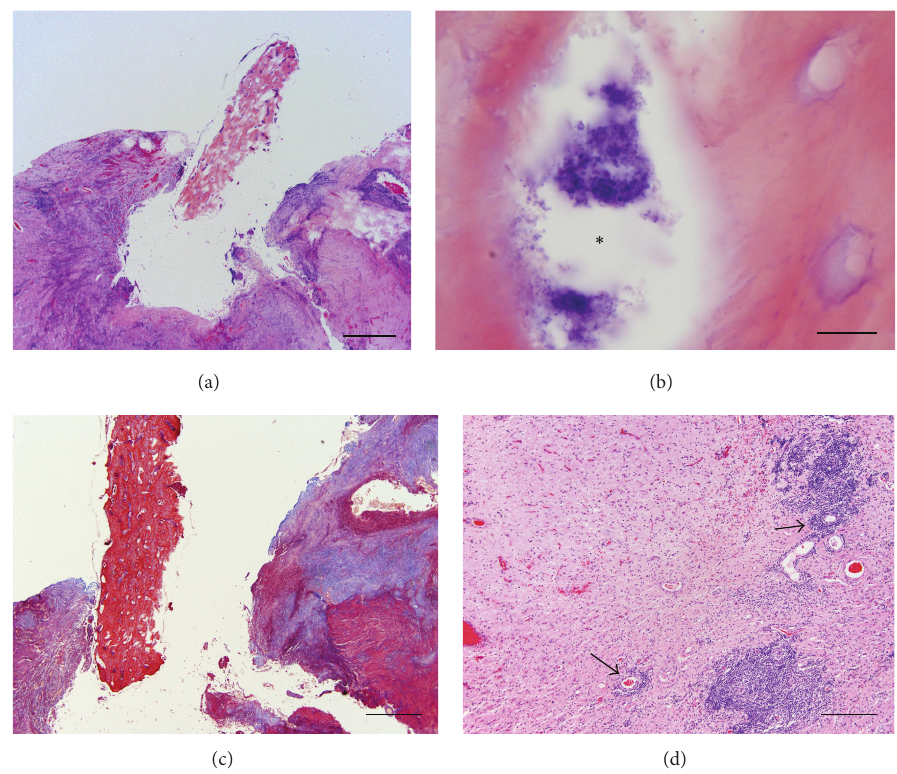
Figure 4: (a) Necrotic bone fragment surrounded by cavitated and inflamed neuropil. Hematoxylin and eosin × 2, scale bar = 650 𝜇 m. (b) Gram-positive cocci within the marrow space (asterisk) of the necrotic bone fragment. Gram stain × 100, scale bar = 8 𝜇 m. (c) Fibrosis (blue) of the neuropil surrounding the necrotic bone fragment (red). Masson’s trichrome stain × 4, scale bar = 400 𝜇 m. (d) Lymphoplasmacytic perivascular cuffs (arrows) and diffuse gliosis throughout the neuropil at the periphery of the sample. Hematoxylin and eosin × 10, scale bar = 175 𝜇